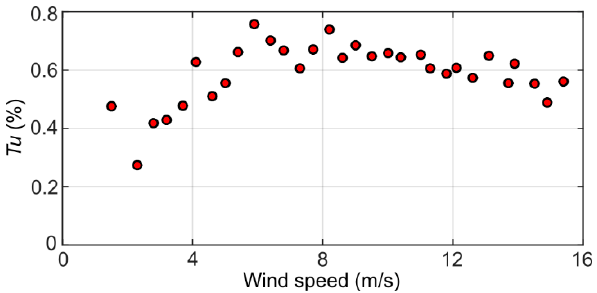
Figure 3. Streamwise turbulence intensity vs. wind speed.